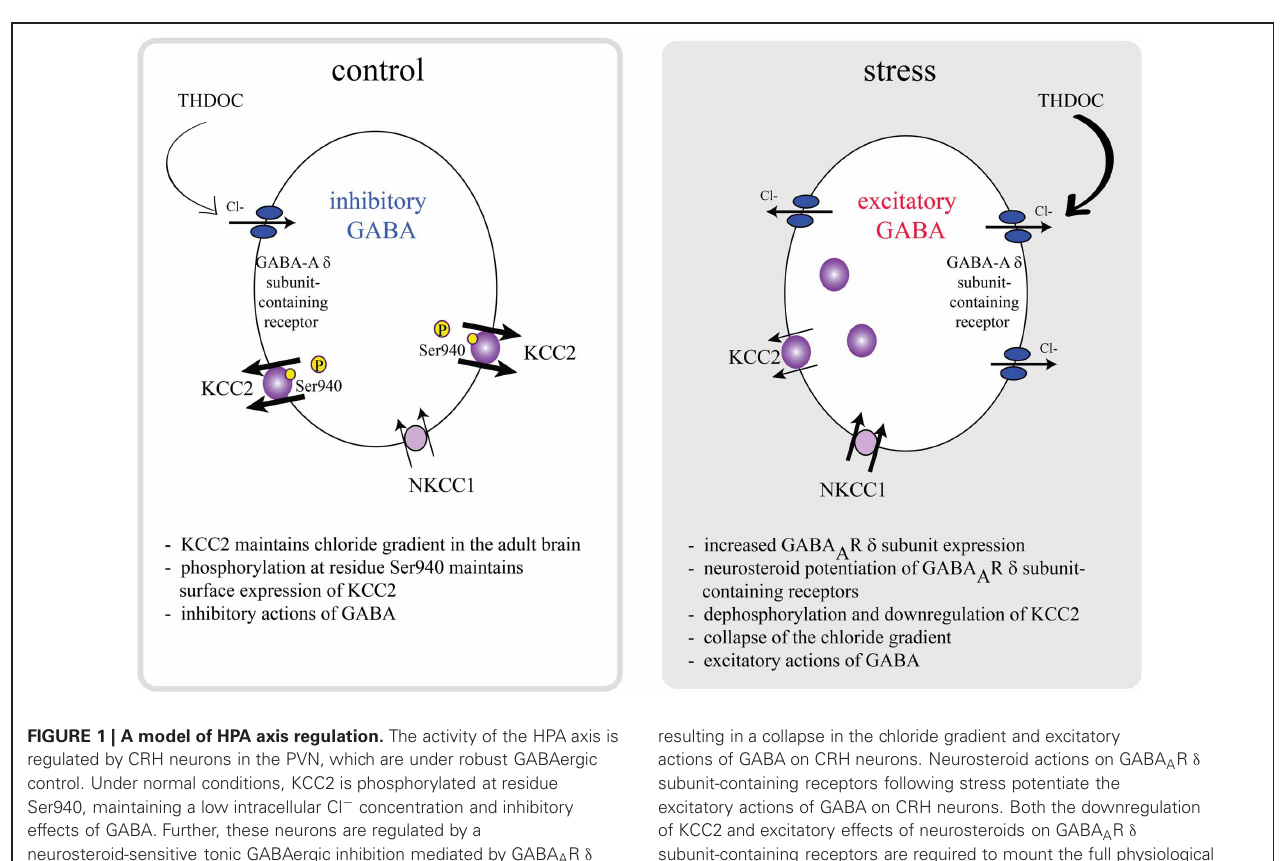
FIGURE 1 | A model of HPA axis regulation. The activity of the HPA axis is regulated by CRH neurons in the PVN, which are under robust GABAergic control. Under normal conditions, KCC2 is phosphorylated at residue Ser940, maintaining a low intracellular Cl − concentration and inhibitory effects of GABA. Further, these neurons are regulated by a neurosteroid-sensitive tonic GABAergic inhibition mediated by GABA A R δ subunit-containing receptors. Following stress, KCC2 residue Ser940 is dephosphorylated and surface KCC2 expression is downregulated,